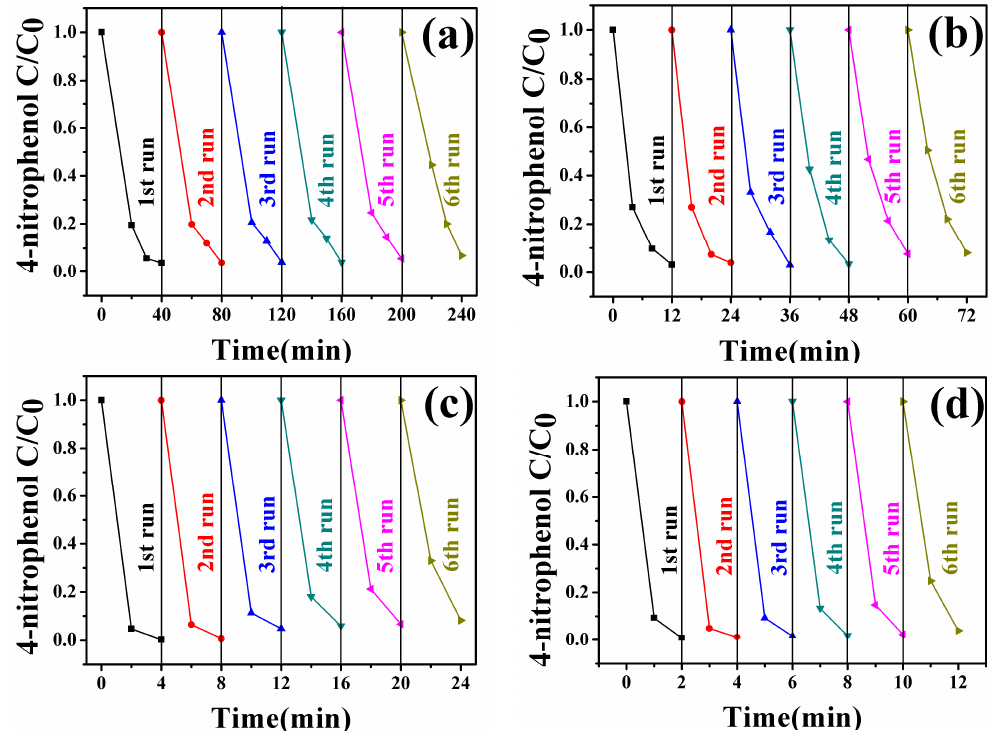
Figure 10. Reusability of Fe 3 O 4 -Au 5 mL ( a ), Fe 3 O 4 -Au 20 mL ( b ), Fe 3 O 4 -Au 40 mL ( c ) and Fe 3 O 4 -Au 60 mL ( d ) for catalytic reduction of 4-NP.